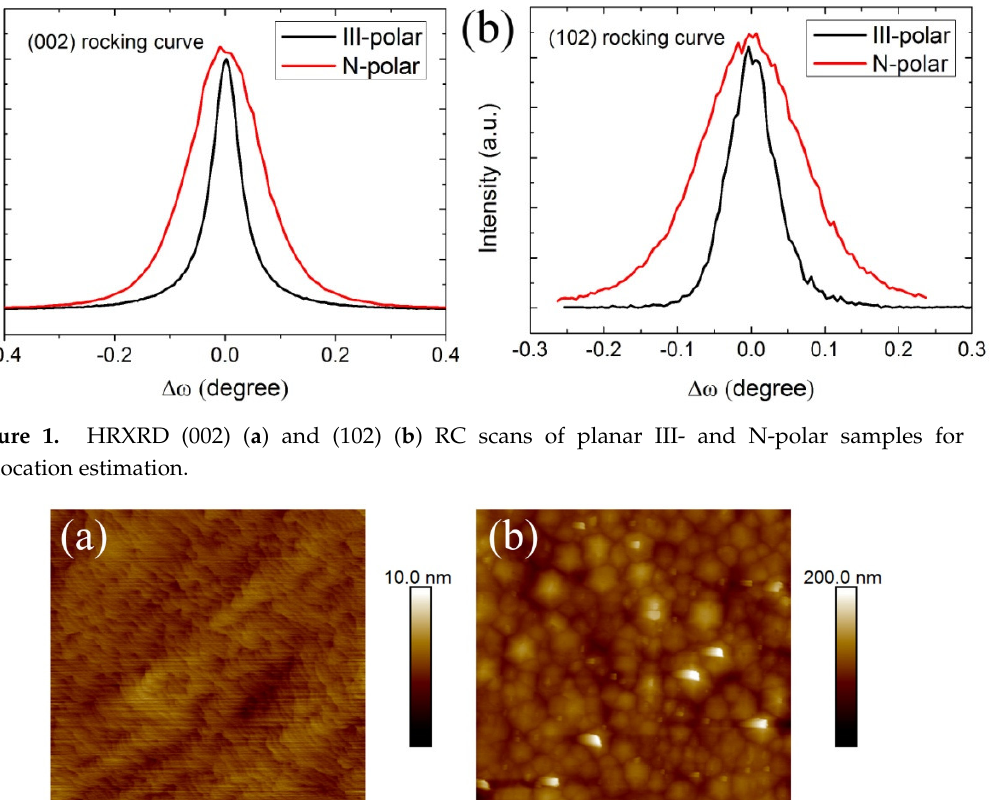
Figure 1. HRXRD (002) ( a ) and (102) ( b ) RC scans of planar III- and N-polar samples for dislocation estimation.